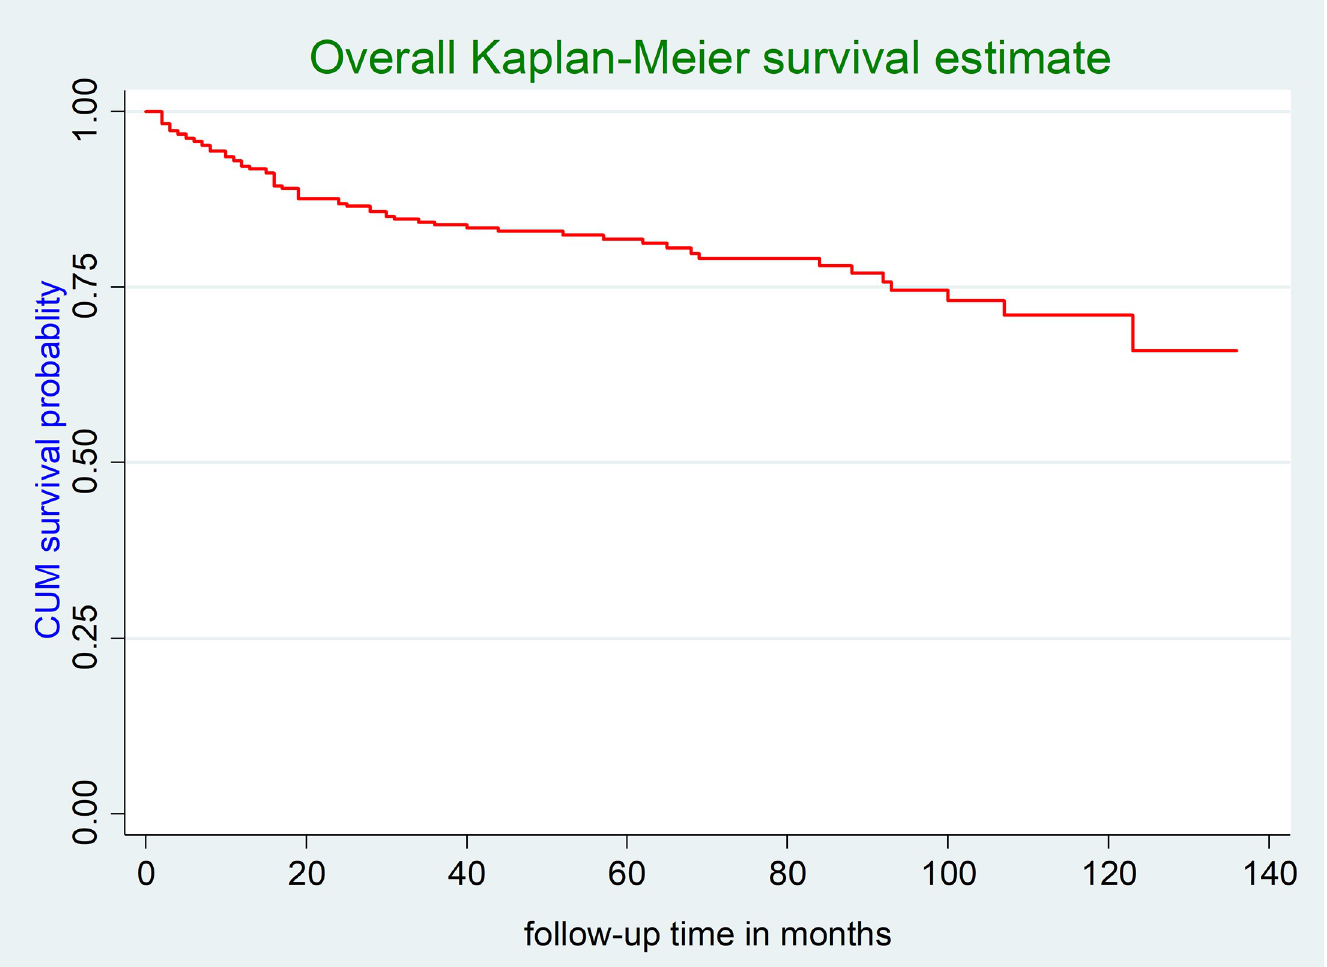
Fig 1. The overall Kaplan-Meier survival curve of LTFU among HIV-infected children receiving ART at Debre-Markos Referral Hospital, Northwest Ethiopia, 2019.